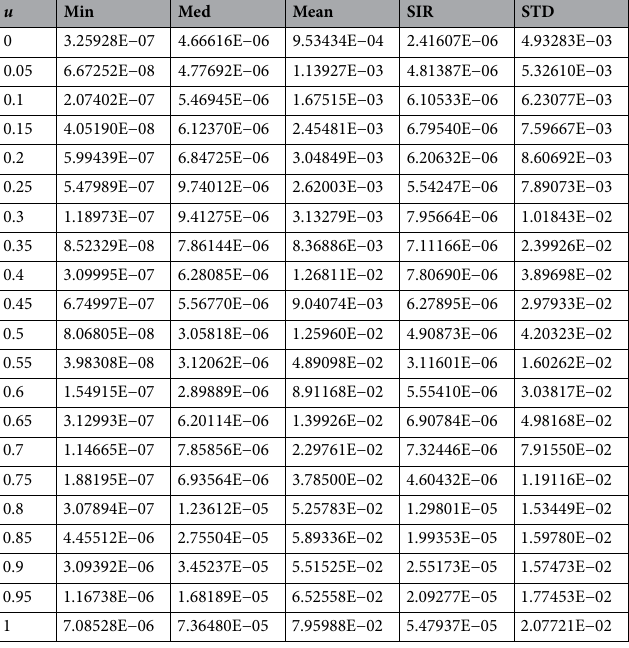
Table 1. Statistical presentations via stochastic performances for solving the novel SO-PSDDM-based Problem 1.